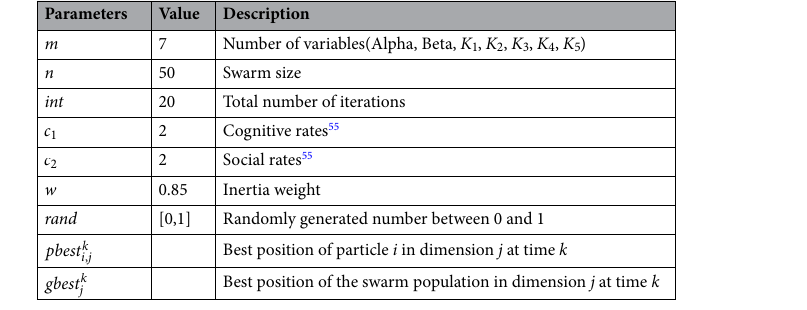
Table 6. Parameters of Eqs. (19) and (20).